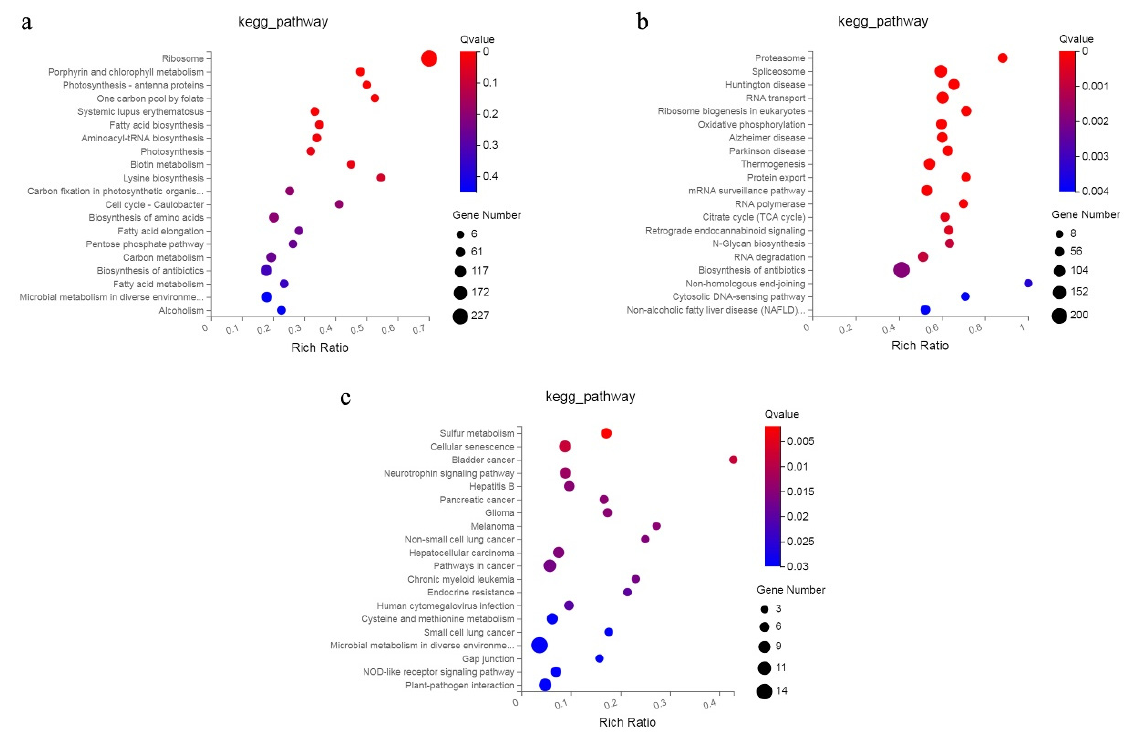
Figure 6. Genes in three modules were analysed using KEGG. ( a – c ) Results for the MElightcyan, MEpink, and MEblue modules, respectively.